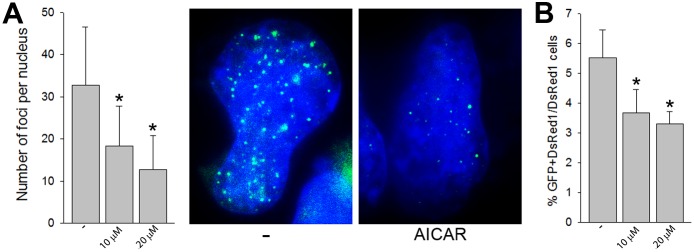
AICAR inhibits RAD52 activity in cells.(A) Number of GFP-RAD52 foci/nucleus (10–30 nuclei/group from 2 experiments) in cisplatin-treated BCR-ABL1 –positive BRCA1-deficient cells pre-incubated, or not, with 10 and 20 μM AICAR; *p<0.001 in comparison to control (-). Representative nuclei with GFP-RAD52 foci from cisplatin-treated cells pre-incubated, or not, with 20 μM AICAR. (B) Percentage of double positive GFP+DsRed1+ cells (RAD52-mediated SSA restored expression of GFP) in DsRed1 population representing SSA activity in U2OS cells treated, or not, with 10 and 20 μM AICAR in 5 independent experiments, *p≤0.004 in comparison to control (-).